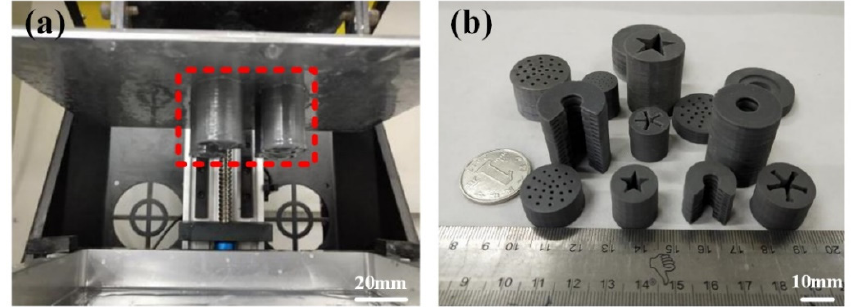
Figure 5. Light-curing 3D printing forming process of special-shaped energetic grains. According to the experimental steps in Figure 5 and the designed 3D models of special-shaped grains, the energetic slurry with a solid content of 52% was printed. The specific printing process is shown in Figure 6a, and the printed energetic grains are hung on the printing platform (red area). After printing, the formed samples are post-processed to obtain different special-shaped grains, as shown in Figure 6b.